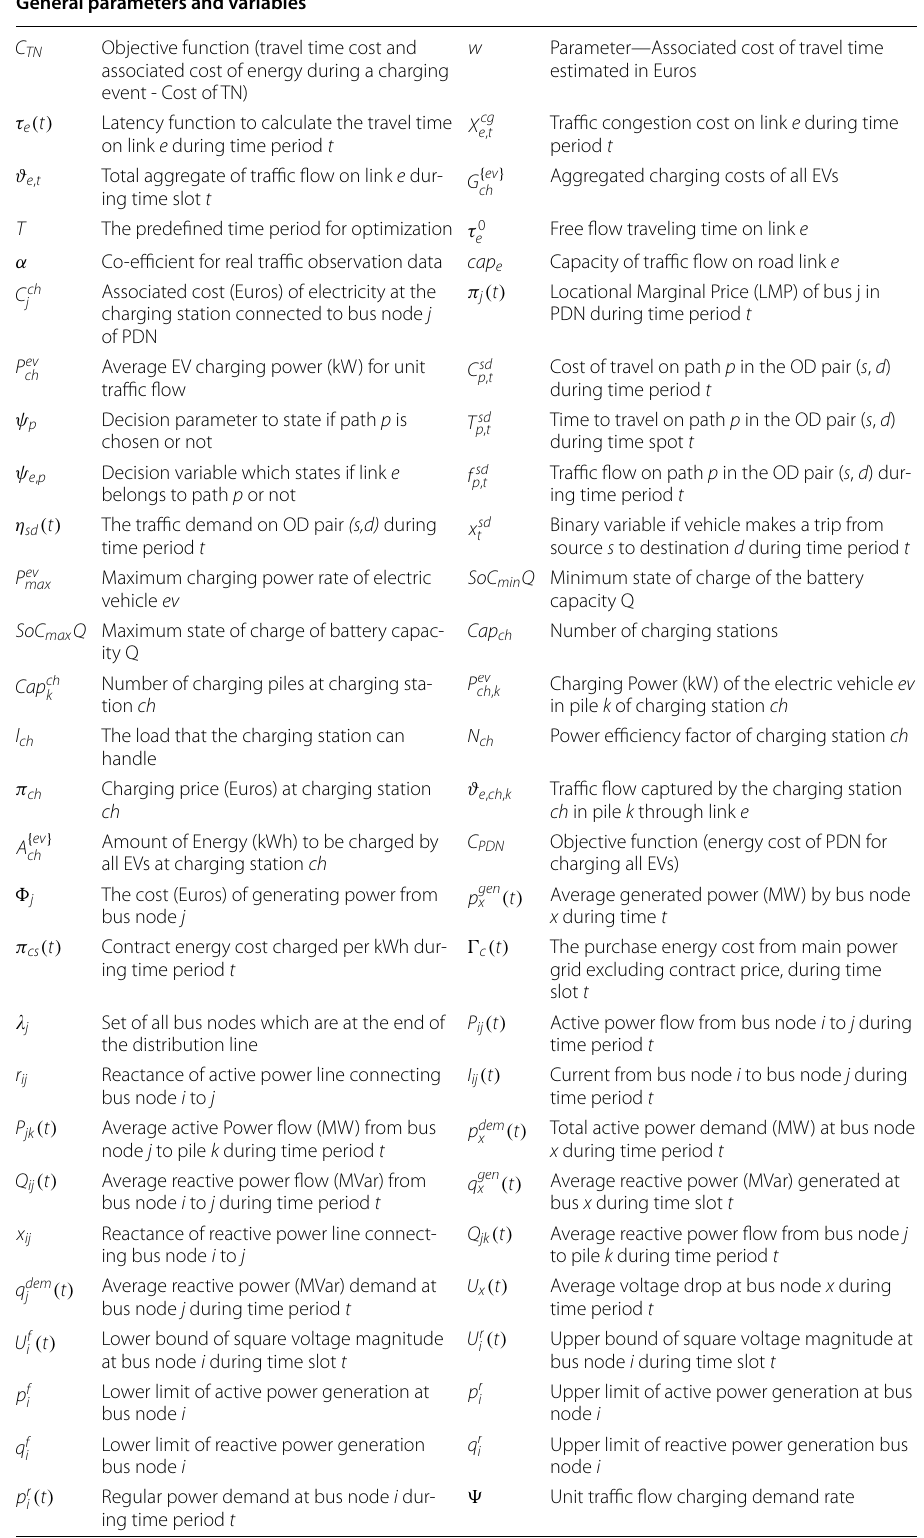
Table 1 Notations summary General parameters and